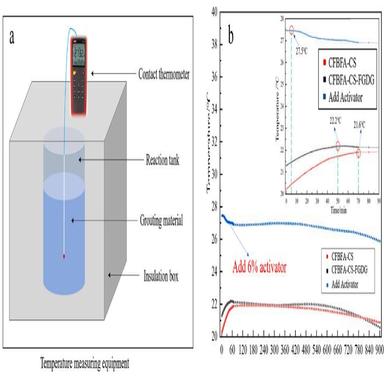
Effect of activator on temperature and rheological properties of composite gelling system (a: temperature measuring equipment, b: temperature change of composite system, c: viscosity of composite system changes with shear rate, d–e: modulus of composite system changes with tension).